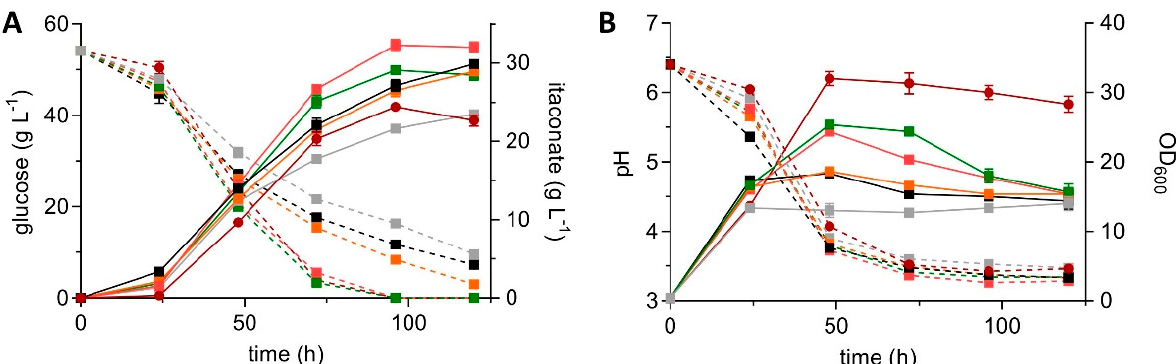
Figure 2. System Duetz ® cultivation of U. maydis MB215 strains expressing mttA in MTM with 50 g L − 1 glucose and 100 mM MES, incubated in 24-well plates with a filling volume of 1.5 mL (shaking diameter = 50 mm, n = 300 rpm, T = 30 °C and Φ = 80%). Itaconate production (continuous lines) and glucose consumption (dotted lines) ( A ) are shown, as well as OD 600 (continuous lines) and pH (dotted lines) ( B ) of U. maydis MB215 ∆ cyp3 ∆ MEL ∆ UA ∆ dgat ∆ P ria1 :: P etef ∆ fuz7 (red) and five P etef mttA transformants named K3 (grey), K8 (green), K9 (orange), K10 (pink), and K14 (black). Error bars indicate the standard error of the mean ( n = 3).